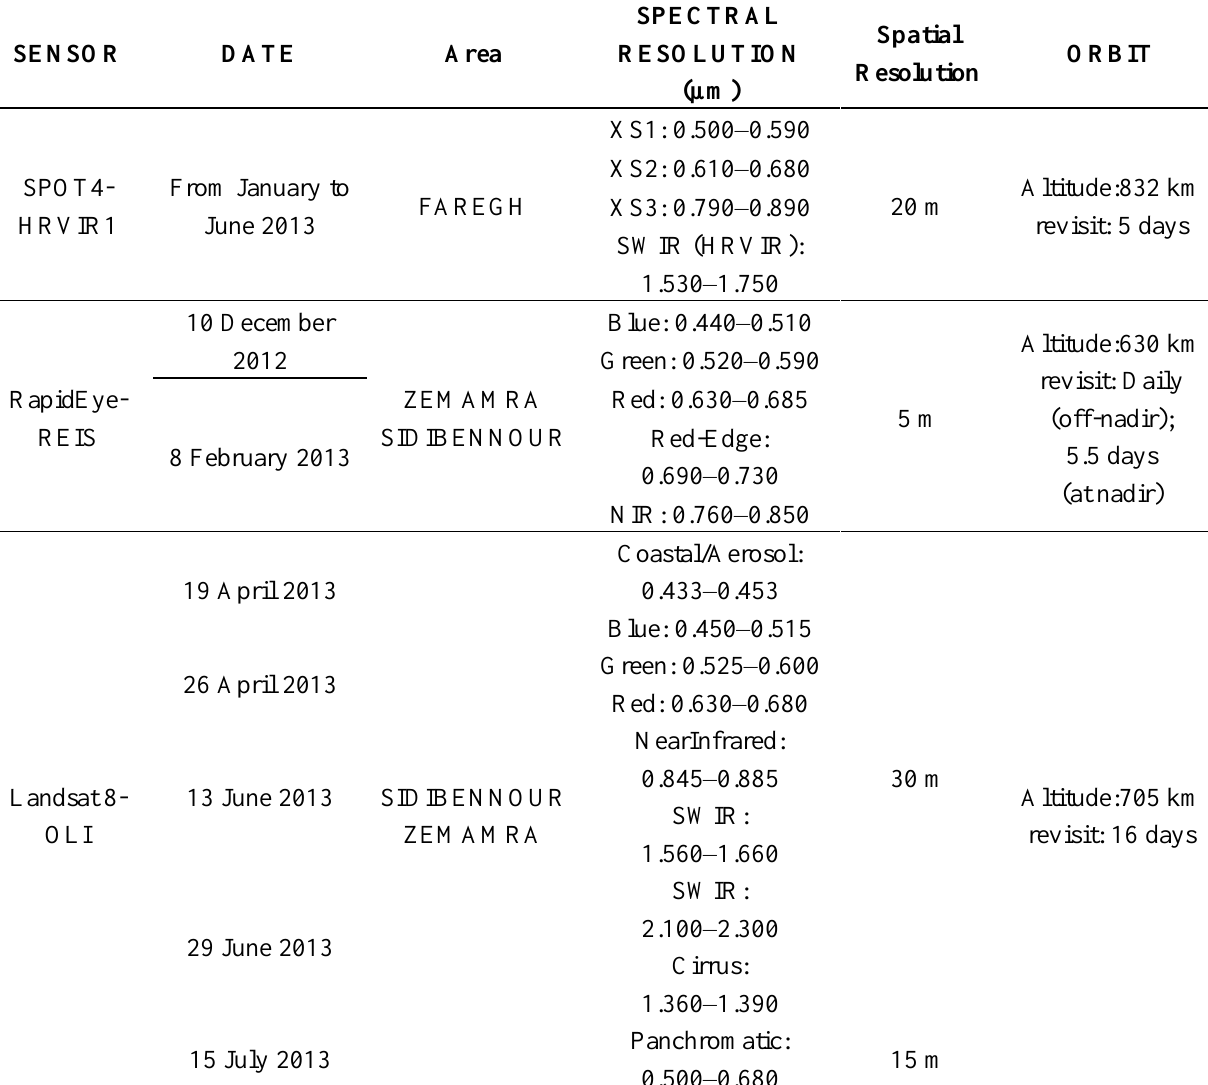
Table 2. Overview of image data characteristics and coverage of the study